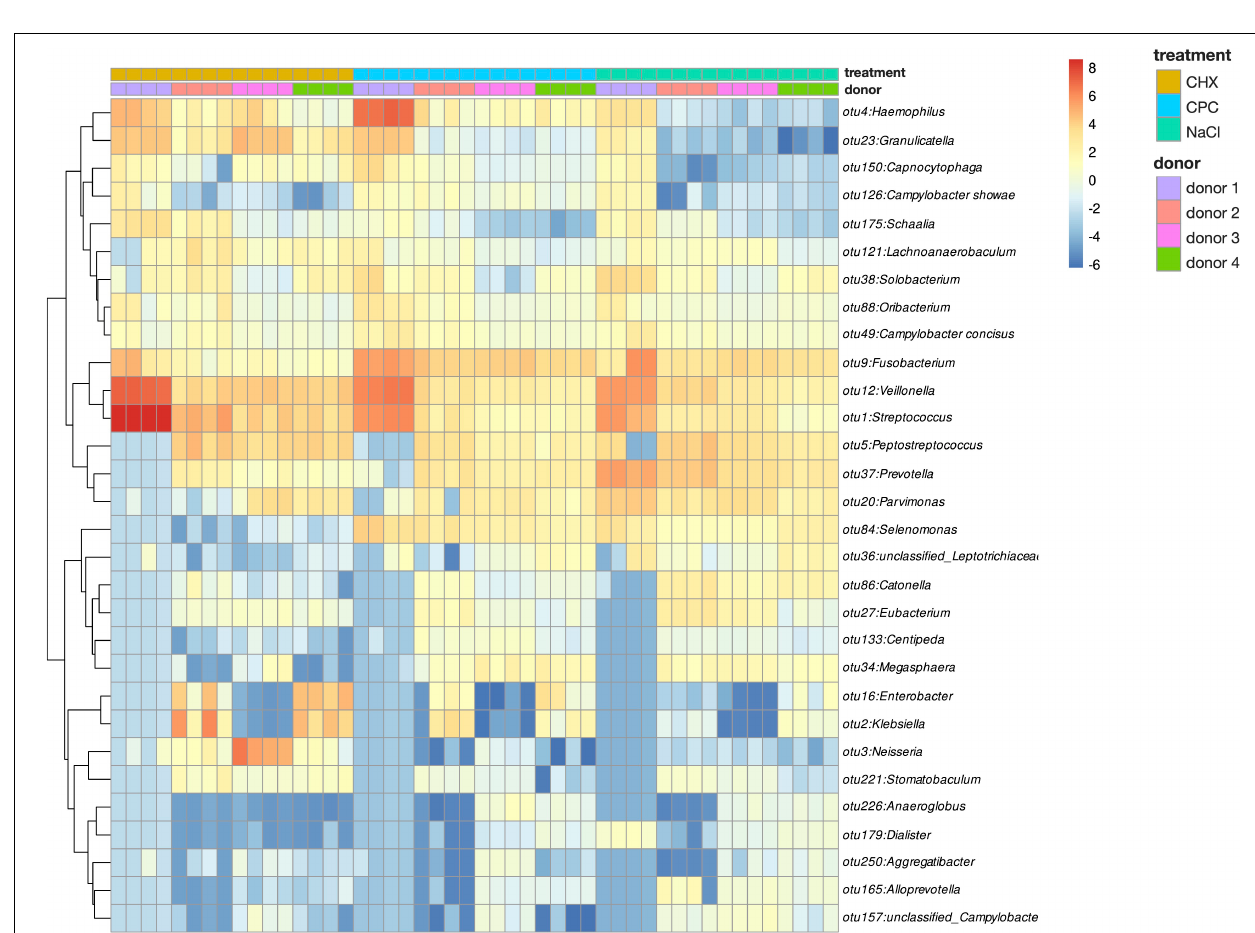
FIGURE 2 | Heatmap of ASV abundance on genus level for NaCl-, CHX-, and CPC-treated biofilms from all four donors.